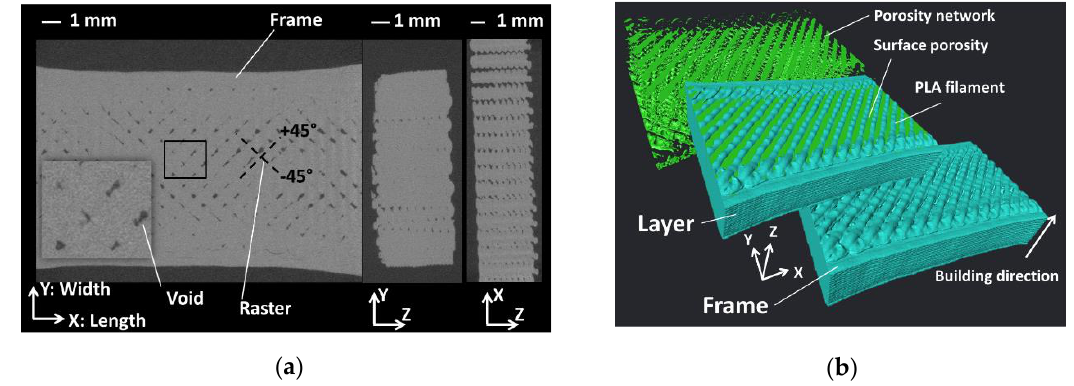
Figure 12. Main microstructural features of the 3D-printed PLA revealed using X-ray micro- Figure12. Mainmicrostructuralfeaturesof the3D-printedPLArevealedusingX-raymicro-tomography: tomography: ( a ) cross-section views; ( b ) porosity network and filament arrangement. ( a ) cross-section views; ( b ) porosity network and filament arrangement.